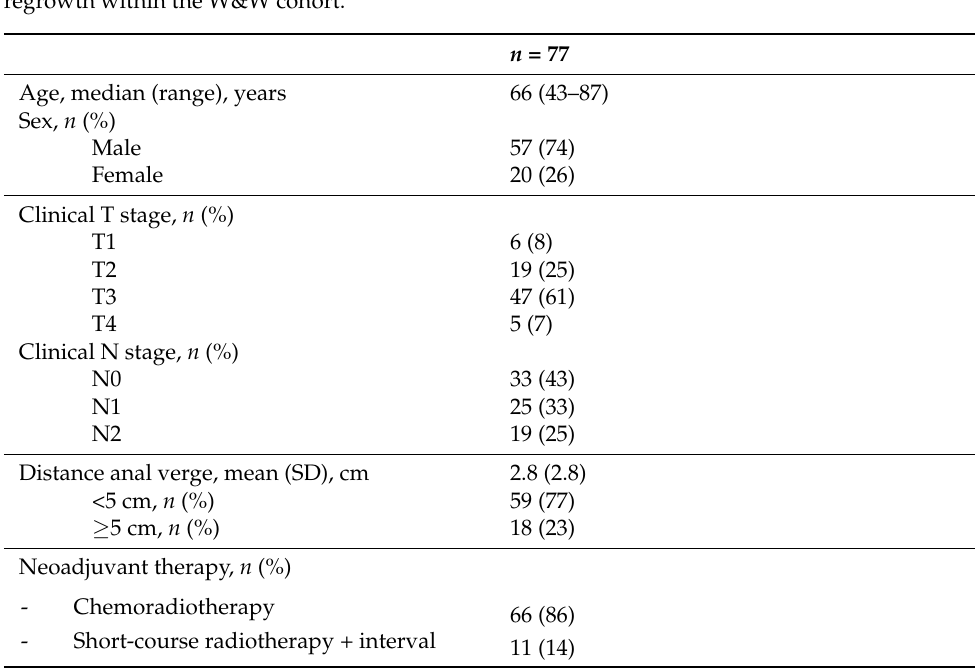
Figure 1. Flowchart depicting patient flow. Abbreviations: W&W = Watch and Wait; TME = total mesorectal excision; * due to widespread metastases, frailty or patient preferences; ** n = 1 salvage TME after second local excision. Table 1. Baseline characteristics of n = 77 patients who underwent local excision for suspected regrowth within the W&W cohort.